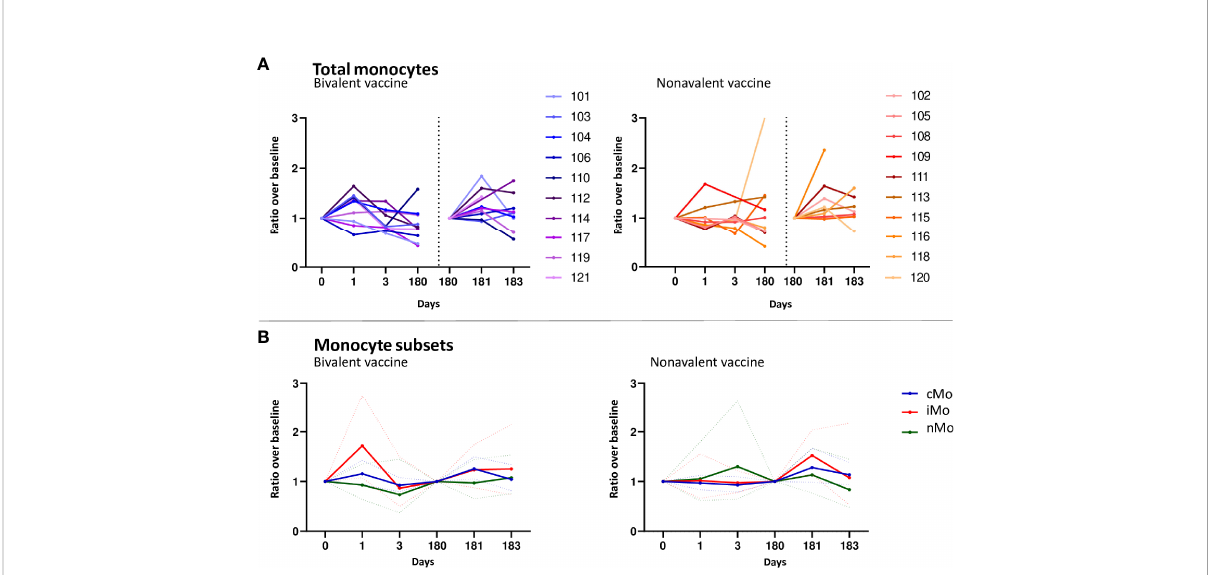
FIGURE 2 Monocyte responses. (A) Kinetics of circulating monocytes upon bivalent (purple-blue) or nonavalent (orange-red) vaccination at day 0, 1, 3, 180, 181 and 183 post vaccination, presented as ratio compared to baseline cell numbers (cells/ m L blood) depicted per individual participant. Participant identi fi cation by color is indicated on the right. The dotted vertical line split the results post 1 st and 3th vaccination. (B) Kinetics of monocyte subsets upon bivalent (left) or nonavalent (right) vaccinations at day 0, 1, 3, 180, 181 and 183, presented as the ratio in numbers compared to baseline numbers (cells/ m L blood) indicated per vaccine cohort. Solid lines indicate the mean ratio of each cohort and the dotted lines represent the upper and lower con fi dence intervals. cMo= classical monocytes (blue), iMo= intermediate monocytes (red) and nMo= non- classical monocytes (green). At day 180, participants received the third HPV vaccination, therefore, this day served as a new ‘ baseline ’ moment to normalize the cell numbers from day 181 and 183, 1 and 3 days post third vaccination,